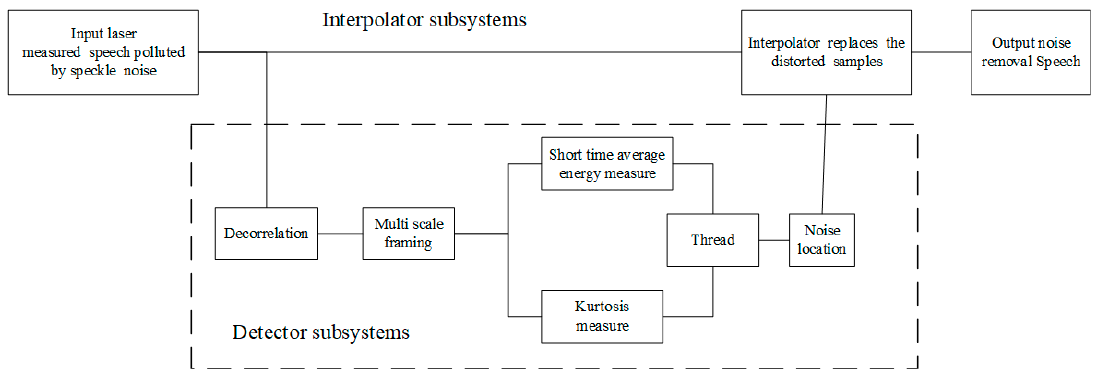
Figure 4. Automatic Detection and Removal of Speckle Noise.